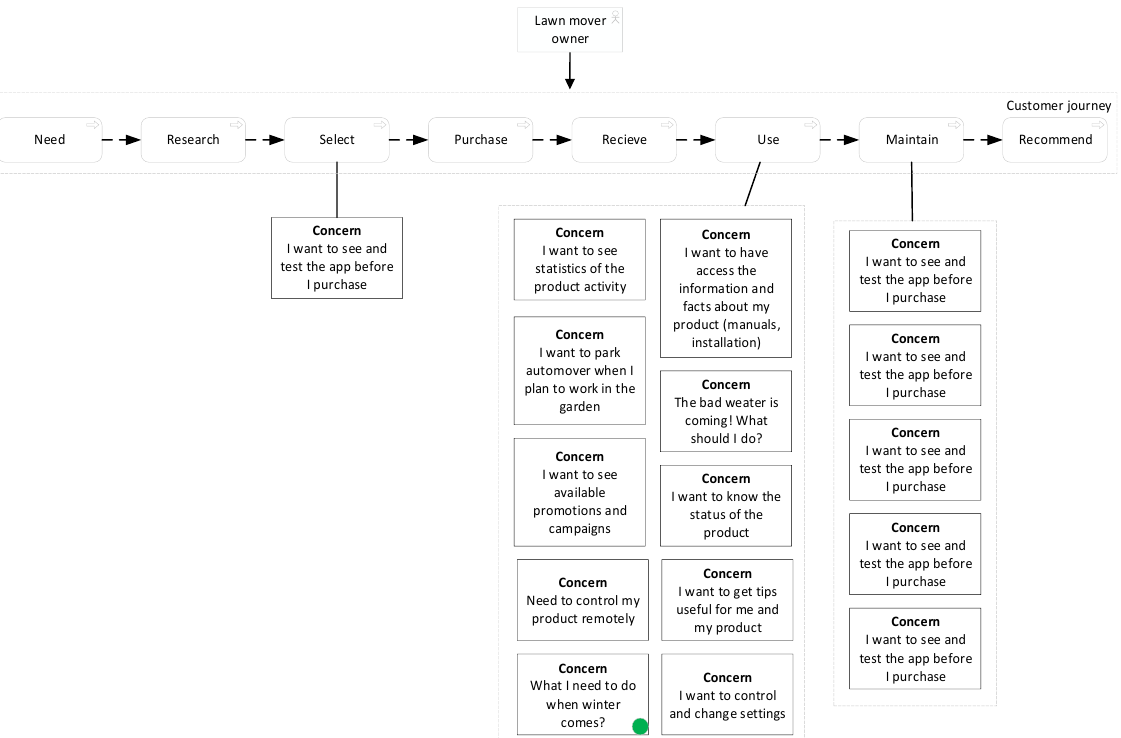
Figure 11. The customer journey and related customer concerns in the context of Lawn Mower Connect mobile app usage